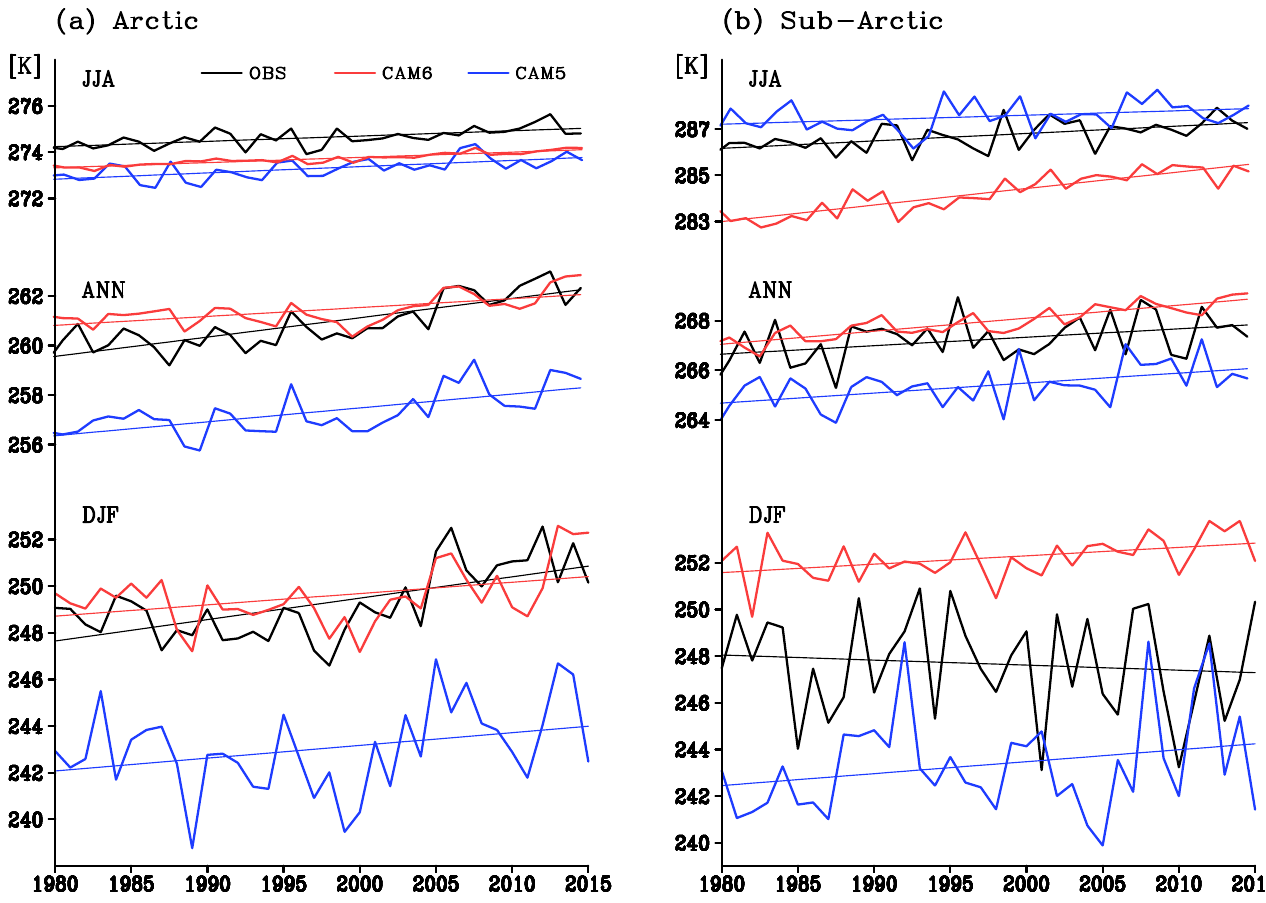
Figure 8. Interannual time series of the surface air temperature (SAT) averaged over ( a ) the Arctic and ( b ) sub-Arctic during ( upper ) JJA, ( middle ) annual mean, and ( bottom ) DJF from ERA-Interim reanalysis (ERA, black lines), CAM6 (red lines), and CAM5 (blue lines). The solid thin lines indicate their linear trend.